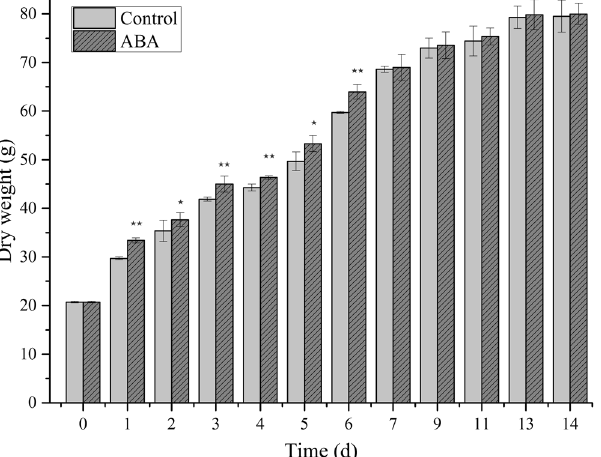
Figure 1. Dry weight accumulation of L. punctata . Each data point represents the mean of triplicate values; error bars indicate standard deviation. * And ** indicate significant differences at the P = 0.05 and P = 0.01 probability level,